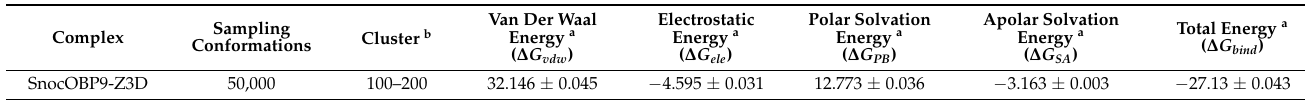
Table 5. The binding free energy of the SnocOBP9-Z3D complex.